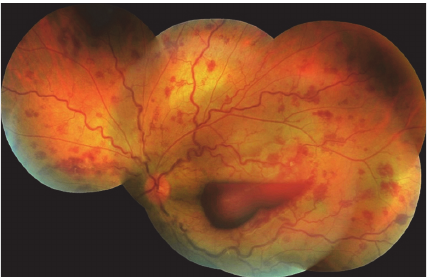
Figure 2: Visual acuity was poor because of subhyaloid premacular hemorrhage.